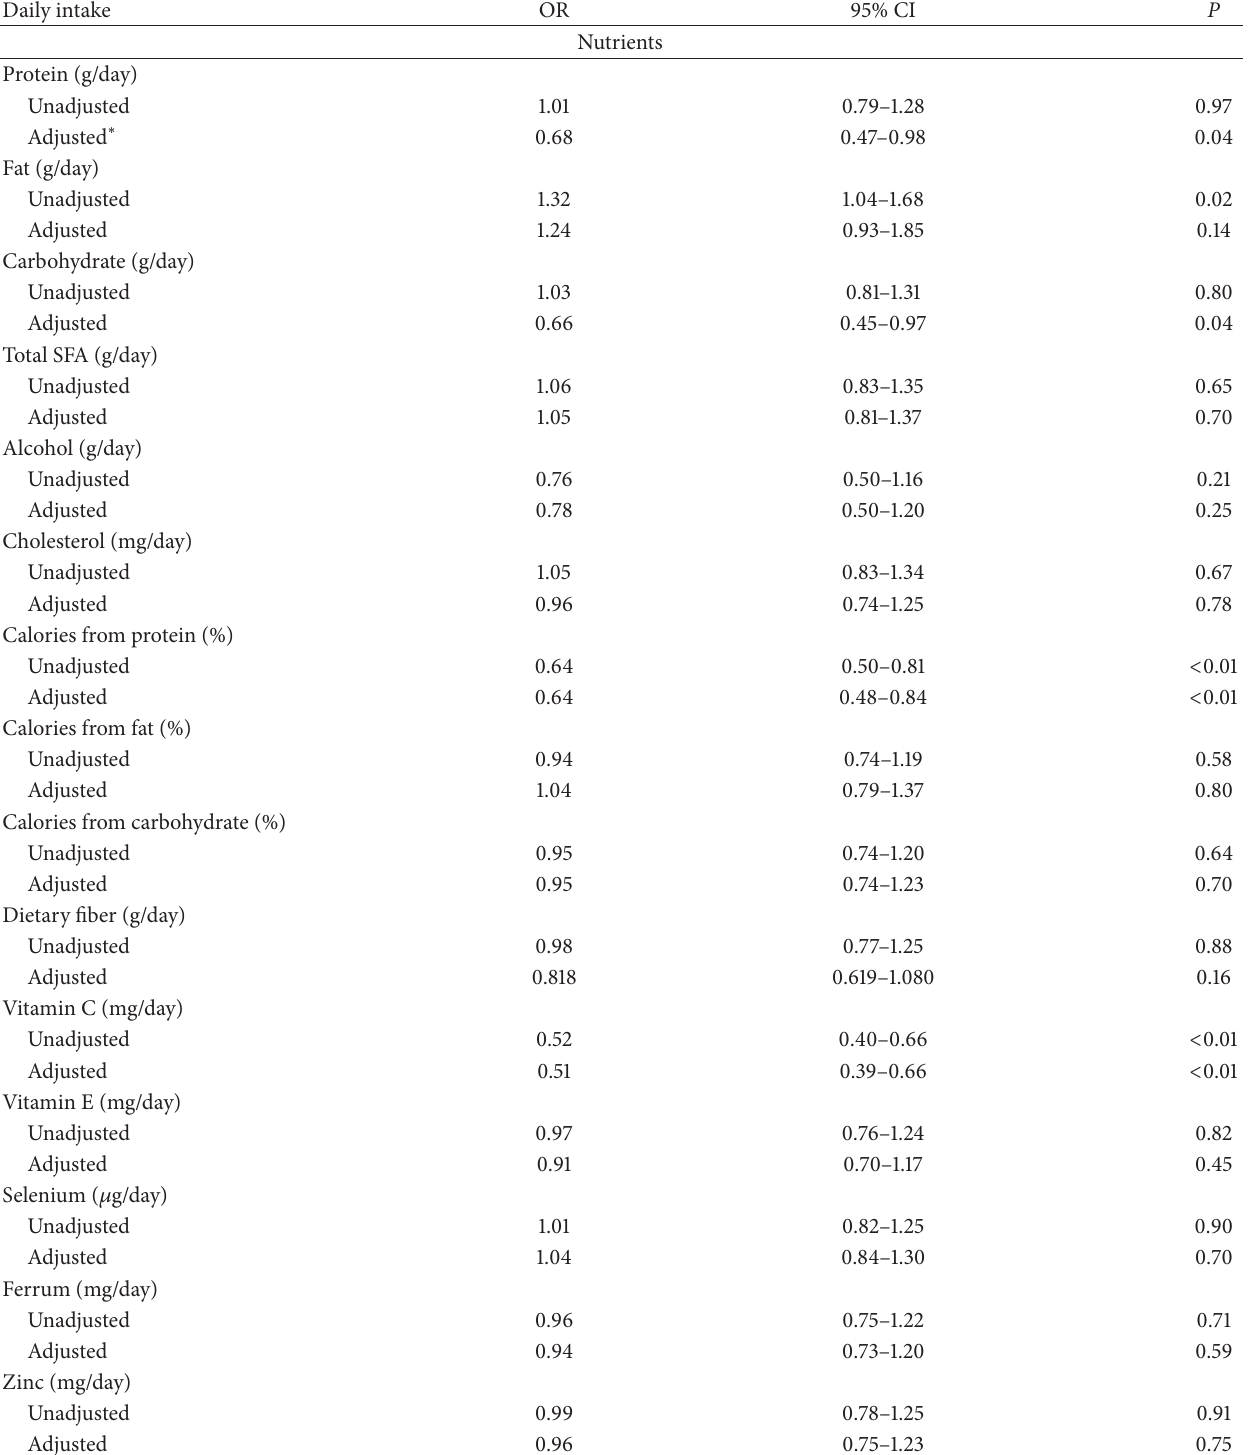
Table 4: Risk for RE in patients with different intake of dietary nutrients and food